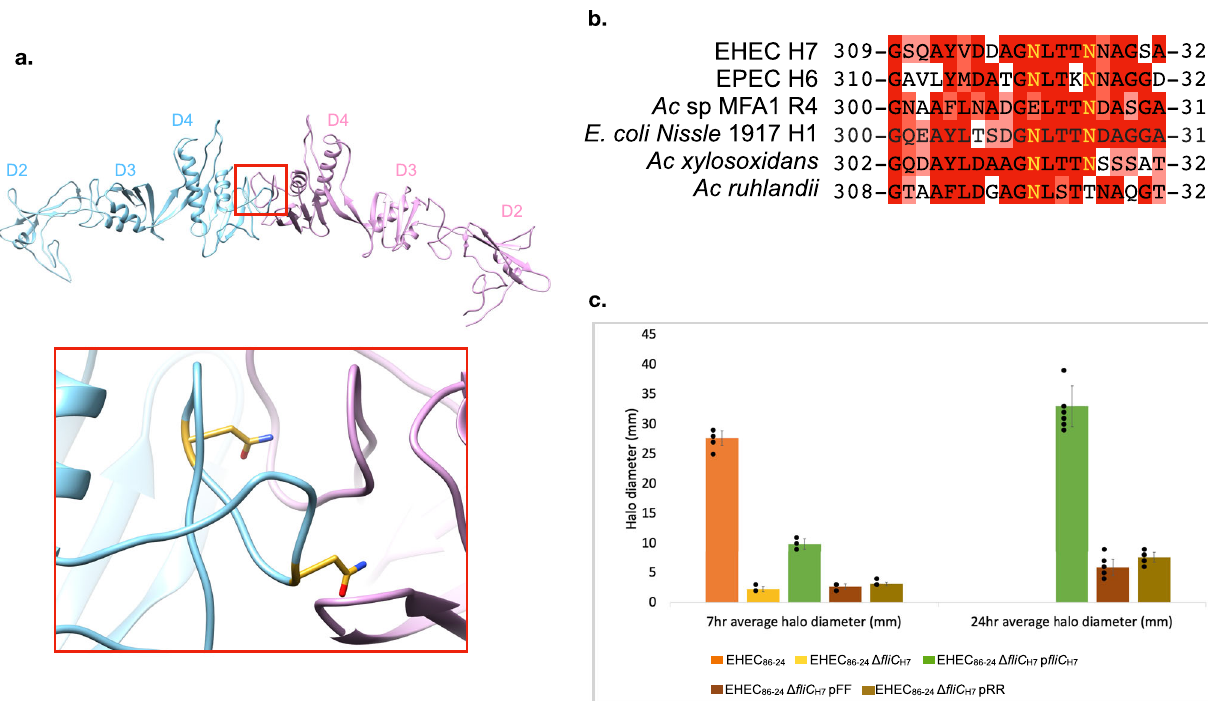
Fig. 6 Mutagenesis of the EHEC H7 outer domain S n :S n + 27 dimer reduces motility. a The S n :S n + 27 dimer is shown with the same color scheme as Fig. 2e. The inset reveals a close-up view of the dimer site. Residues that were mutated are shown in gold in the cyan subunit. b Multiple sequence alignment of the D4 dimer site for EHEC H7, EPEC H6, Achromobacter sp. MFA1 R4, E. coli Nissle 1917, Achromobacter xylosoxidans and Achromobacter ruhlandii fl agellins. The two asparagine residues that were mutated in EHEC H7 (gold) are conserved with the exception of a glutamate residue in the second position in the Achromobacter fl agellin. Sequences are colored by the conservation of chemical properties. c Soft agar (0.3 %) motility assay for EHEC 86 – 24 strains after 7 and 24 h. Data for the wild type (EHEC 86 – 24 ) and wildtype with fl iC deletion (EHEC 86 – 24 Δ fl iC H7 ) are not shown for the 24-h as the EHEC 86 – 24 covered the entire plate and EHEC 86 – 24 Δ fl iC H7 showed no change. The pGEN- fl iC strain complements the Δ fl iC deletion strain. The FF and RR mutants were generated with the pGEN- fl iC strain. Each bar represents the average halo diameter on the plate for each condition. A total of nine soft agar plates was measured for each condition. The black dots overlayed over each graph represent the data individual data points from which the bar graph was made from. The error bars represent the standard deviation for each